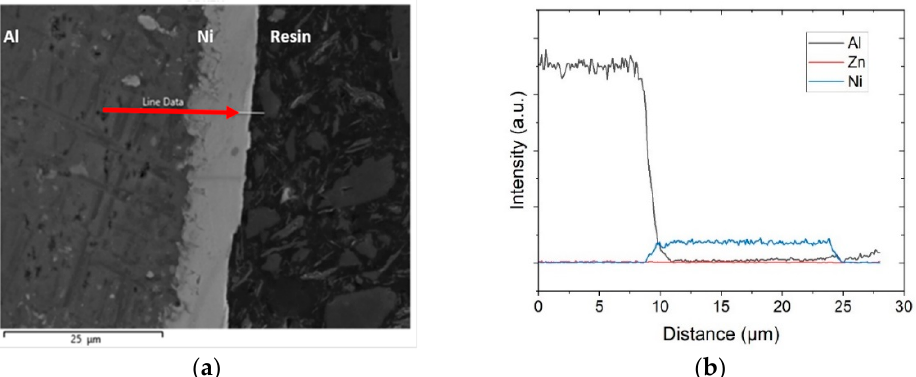
Figure 5. Unpolished sample subjected to the pre-treatment, zinc immersion plating and nickel electroplating for 20 min: ( a ) cross-section being analysed, red arrow indicates the area and the direction of the EDS measurement; ( b ) EDS profile analysis along the red arrow of Al, Zn and Ni.